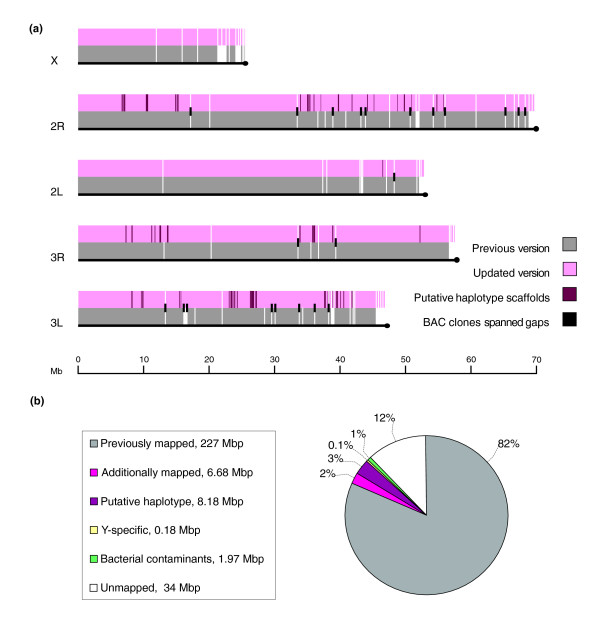
A comparison of the initial and updated versions of the Anopheles gambiae genome assembly.(a) The scaffolds from the previous and updated versions of the genome are shown by gray and pink bars, respectively. Purple stripes on the scaffolds indicate alternative haplotype scaffolds with sizes bigger than 50 kbp. Black bars correspond to the BAC clones that cross inter-scaffold gaps. (b) The updated status of the A. gambiae genome project. Sectors correspond to the previously mapped scaffolds, additionally physically mapped scaffolds, alternative haplotype scaffolds, Y-specific scaffolds, bacterial contaminant scaffolds and the remaining scaffolds that are not assigned to the chromosomes.